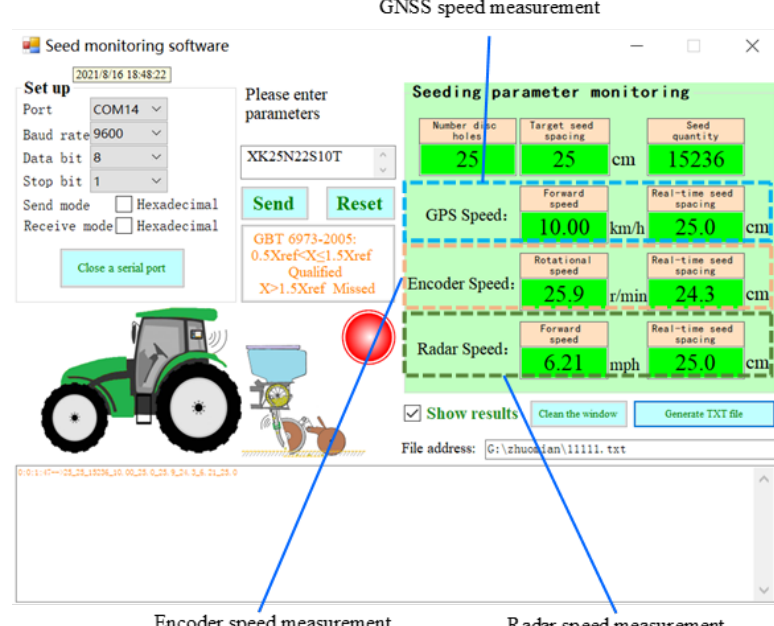
Figure 8. The design of the monitor software.